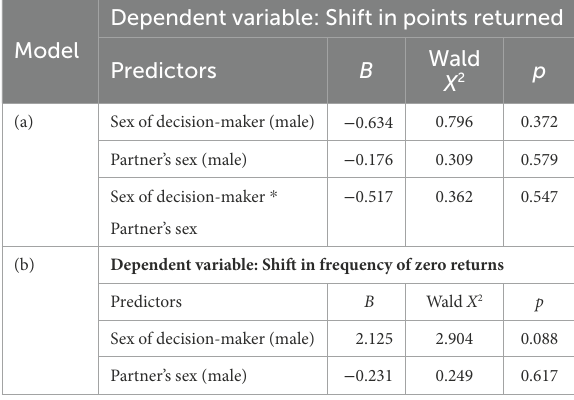
FIGURE A2 Shifts in trustworthiness, partners’ facial femininity and partners’ sex. Association between shifts in trustworthiness and facial femininity for interaction partners of both sexes (the figure depicts direction of the only significant association presented in Table A2), N [interactions] = 560, N [partners] = 20.